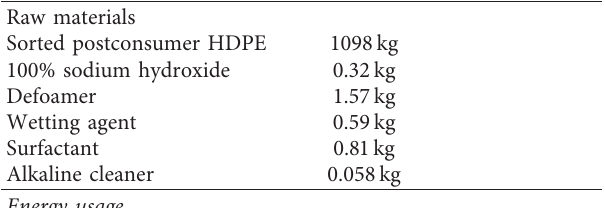
Table 5: Energy requirement for 1 ton of the postconsumer ma- terial at the material recovery facility